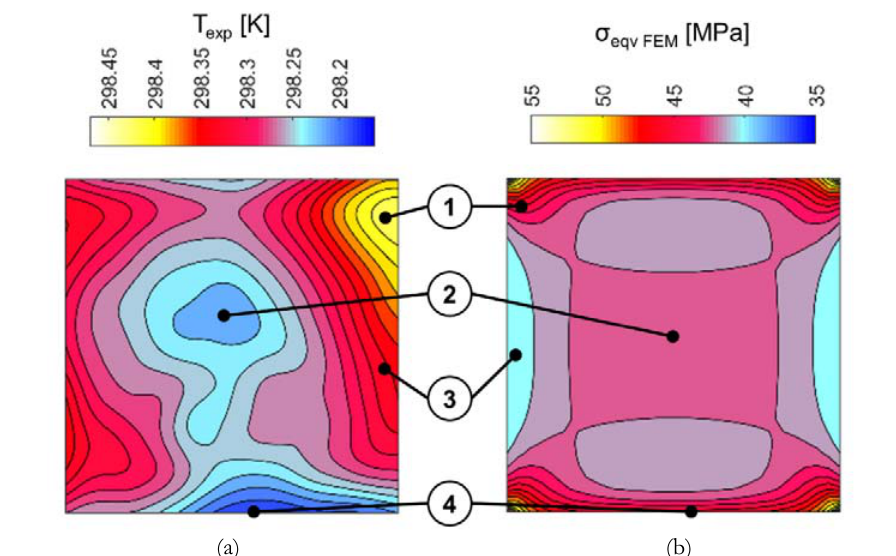
Figure 12: a) Thermal map and b) FEM Equivalent von Mises Stress for the critical load (1000 kN).